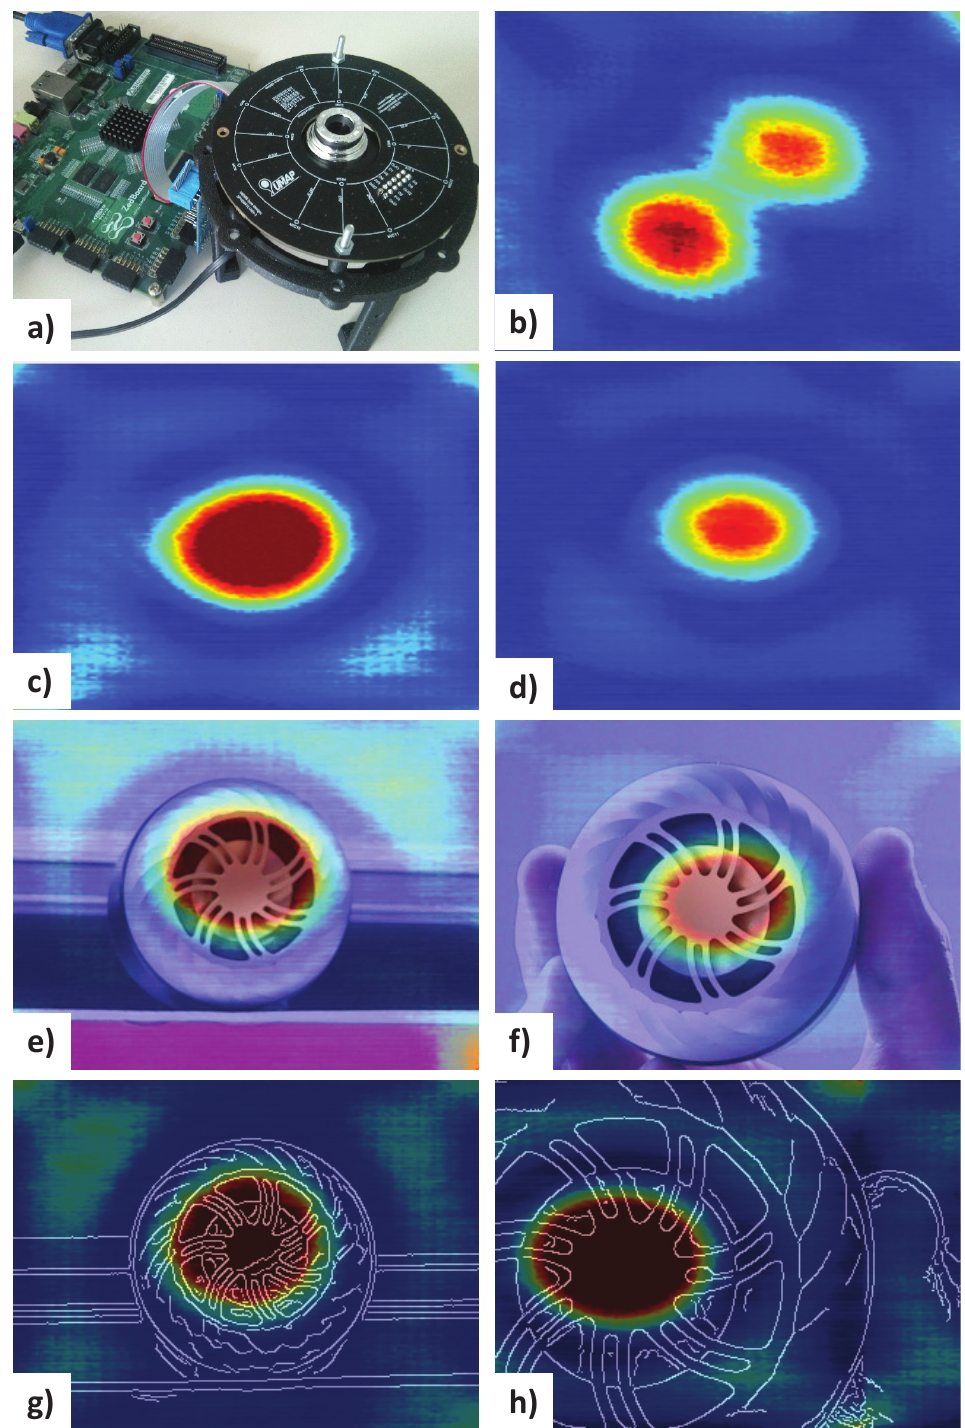
Figure 9. The M3-AC system consisting of the zedboard, microphone array and RGB camera used during the experiments ( a ). Acoustic hetamap of 320 240 with 2 scaling showing two sound sources ( b ), a single sound source of 4kHz half a × × meter ( c ) and one meter ( d ) away. The acoustic heatmaps can also be combined with unmodified images from the RGB camera ( e , f ) or after applying edge detection on the RGB frame ( g , h